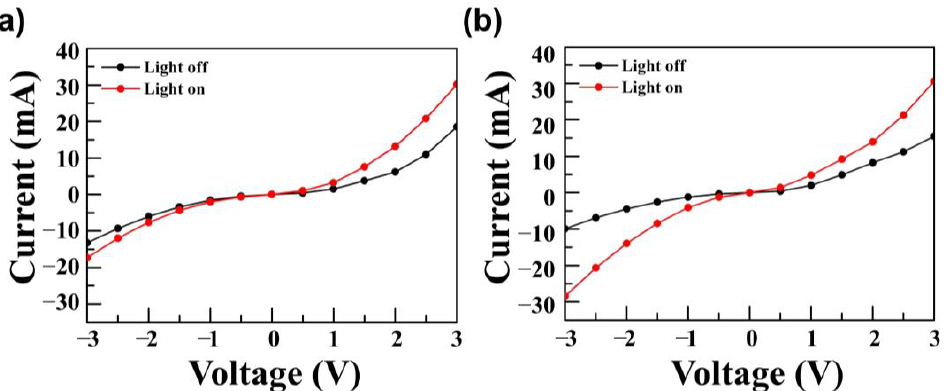
Figure 5. I-V characteristics of fabricated SWIR photodetector: ( a ) PbS QD-based device and ( b ) hybrid P3HT:PbS QD-based device.